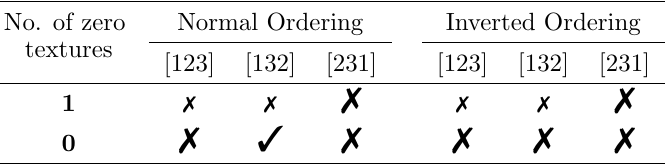
Table 3 . Summary of the numerical results. A texture labeled with a large x-mark ( that the conditions C 1 ; 0 = 0 cannot be satis(cid:12)ed. A small x-mark ( 7 ) indicates that C 1 ; 0 = 0 can only be obtained for values of (cid:18) 23 or (cid:22) 0 that are experimentally excluded. The checkmark the texture [132] with no texture zero highlights the only viable